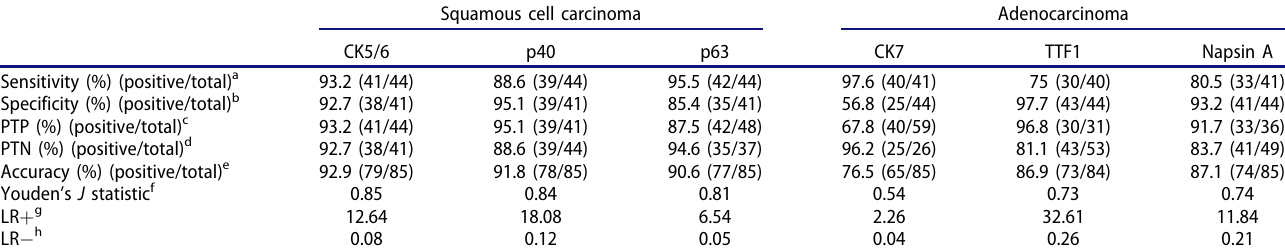
Table 1. Conventional marker expression. Sensitivity, specificity, percentage of true positives and percentage of true negatives, accuracy, Youden ’ s J statistic, and positive and negative likelihood ratio values for staining with markers conventionally used for the differential diagnosis of adenocarcinoma (CK7, TTF1, and Napsin A) and squamous cell carcinoma (CK5/6, p40, and p63).